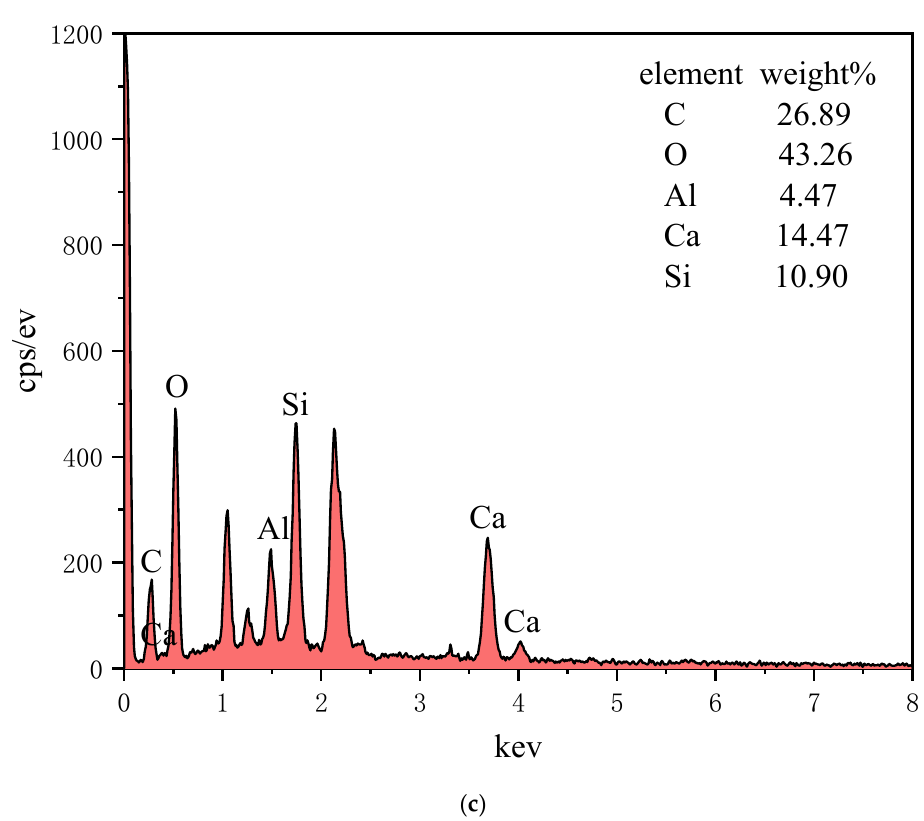
Figure 6. RHA1 microgram. ( a ) Micromorphology of RHA1. ( b ) Upper right arrow in figure. ( c ) Lower right arrow in figure.